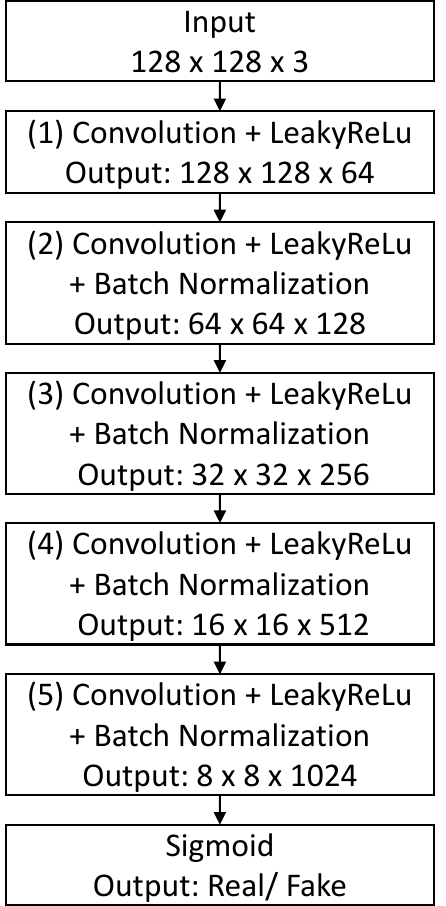
Figure 4. Discriminator Network